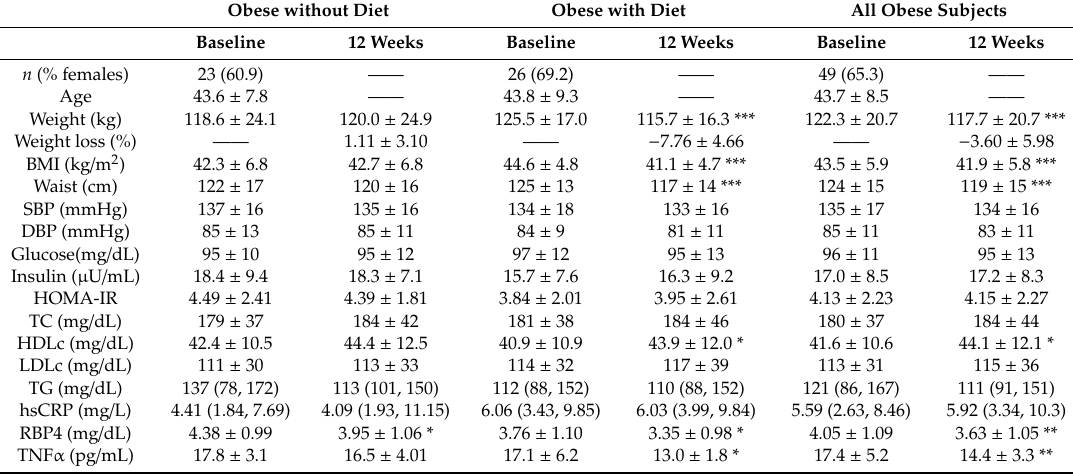
Data represent mean ± standard deviation for parametric data and median (25th and 75th percentiles) for non-parametric data. * p < 0.05; ** p < 0.01; *** p < 0.001 when data of diet vs. no diet groups were compared at baseline and 12 weeks by a paired Student’s t -test for parametric data or by a Wilcoxon test for non-parametric data. Abbreviations: BMI: body mass index, SBP: systolic blood pressure, DBP: diastolic blood pressure, HOMA-IR: homeostasis model assessment of insulin resistance, TC: total cholesterol, HDLc: HDL cholesterol, LDLc: LDL cholesterol, TG: triglycerides, hsCRP: high sensitive C-reactive protein, RBP4: retinol-binding protein 4, TNF α : tumor necrosis factor